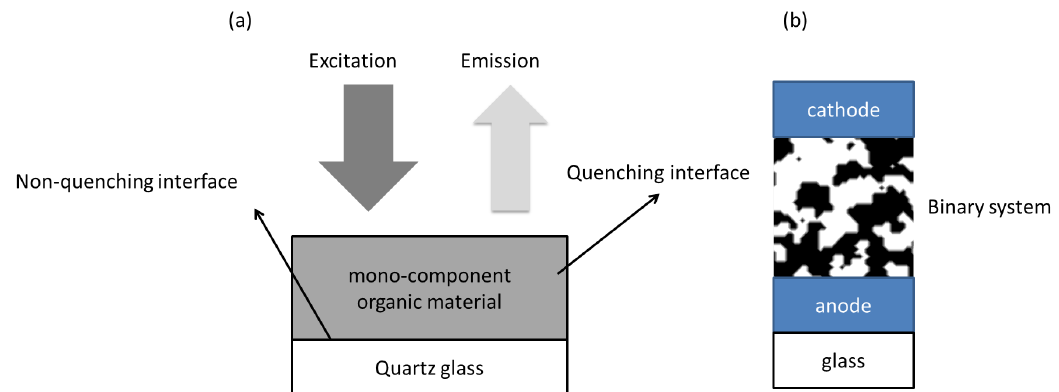
Figure 4. A typical sample for ( a ) single material PL measurements and ( b ) OPV